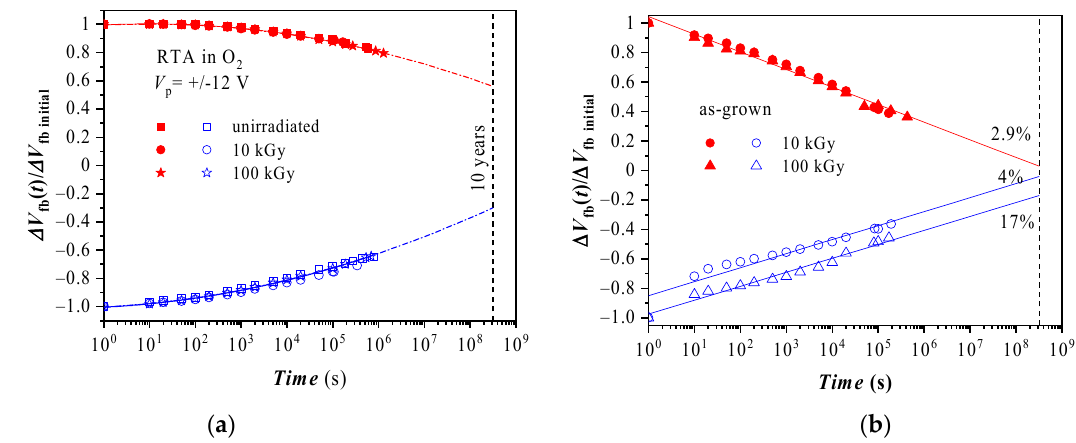
Figure 7. Retention characteristics of stacks annealed in oxygen ( a ) before and after irradiation, and ( b ) irradiated as-grown stacks.